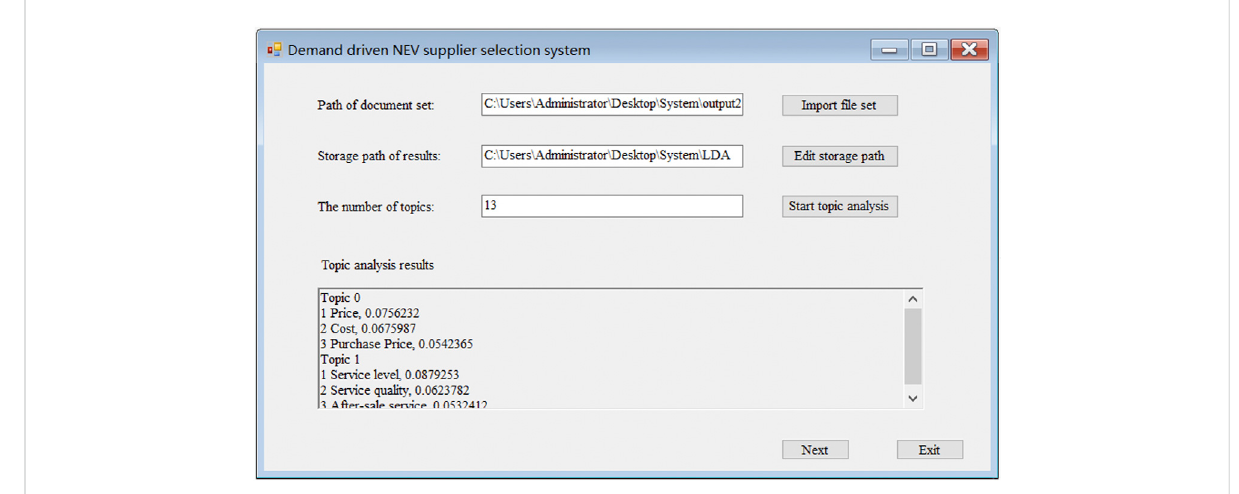
FIGURE 7 Topic analysis result interface.